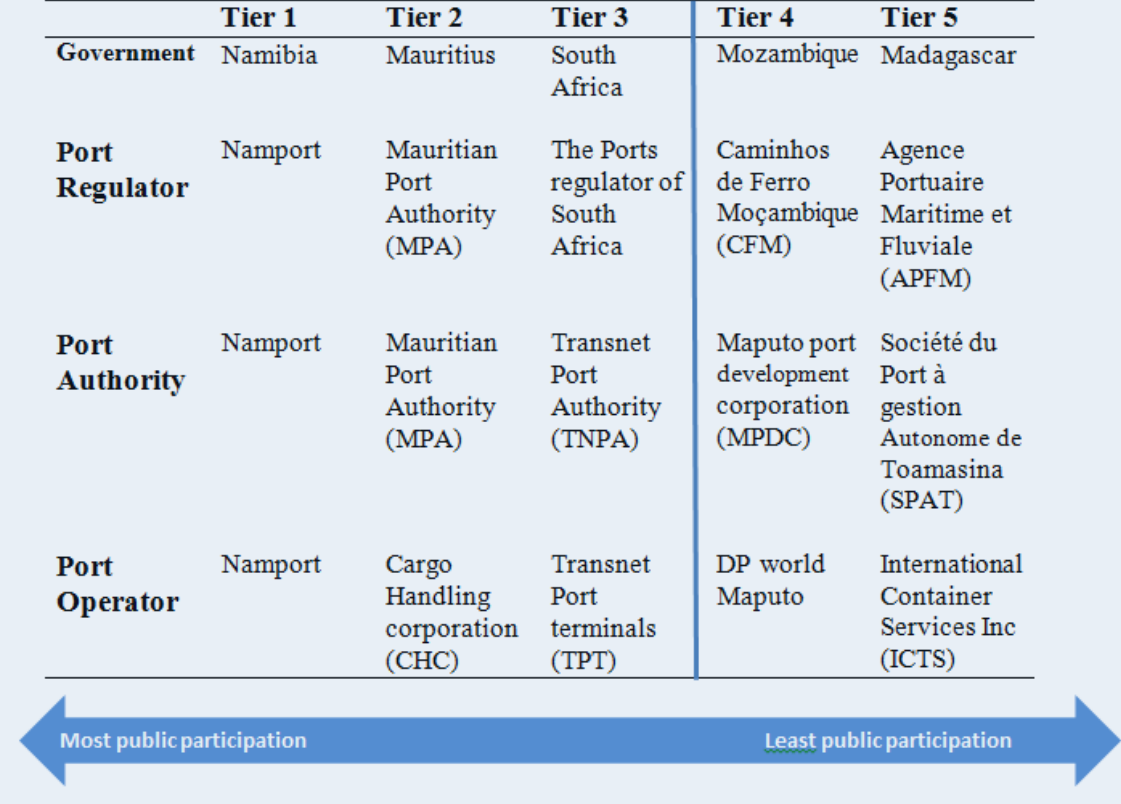
Figure 4. Institutional variation of Southern African